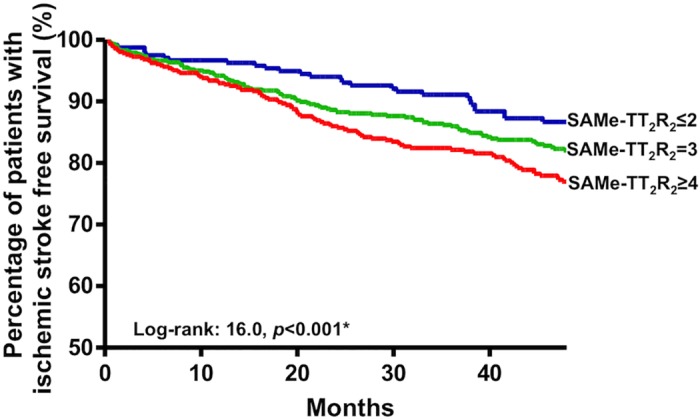
Kaplan-Meier estimates of ischemic stroke-free survival in Chinese AF patients with different SAMe-TT2R2 scores.